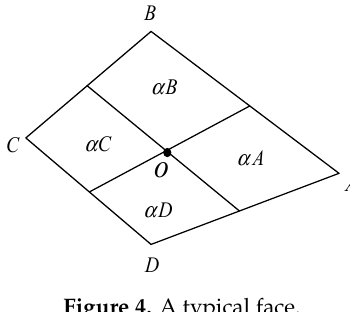
Figure 4. A typical face. Figure 4. A typical